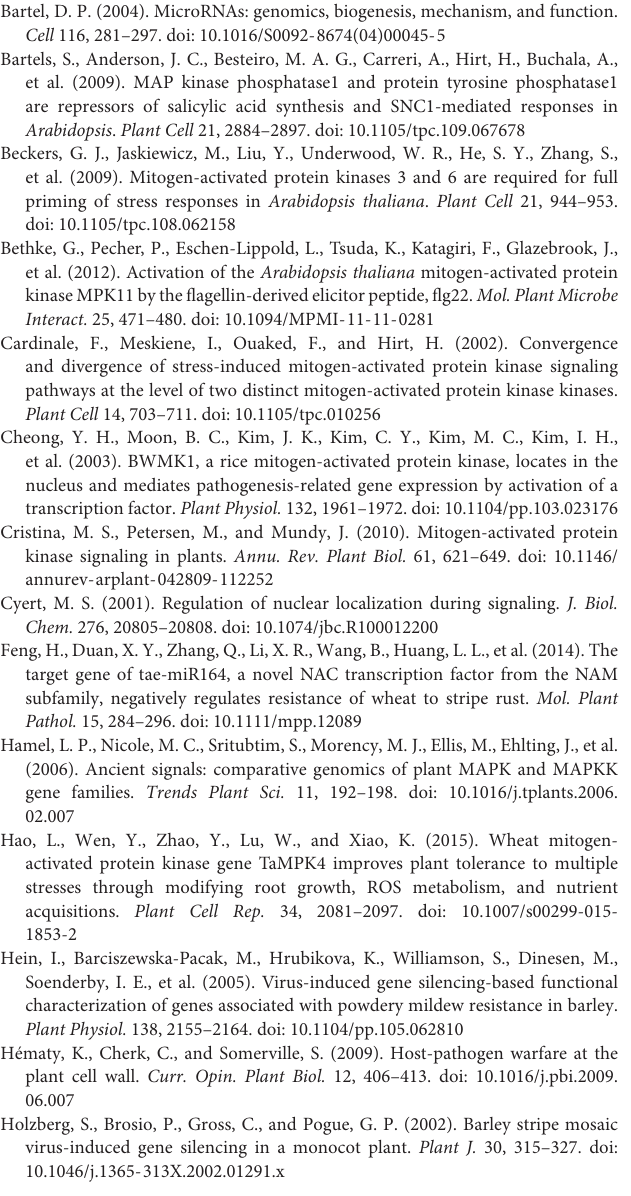
TABLE S1 | Prediction of tae-miR164 target in wheat. TABLE S2 | Primers designed for TaMAPK4